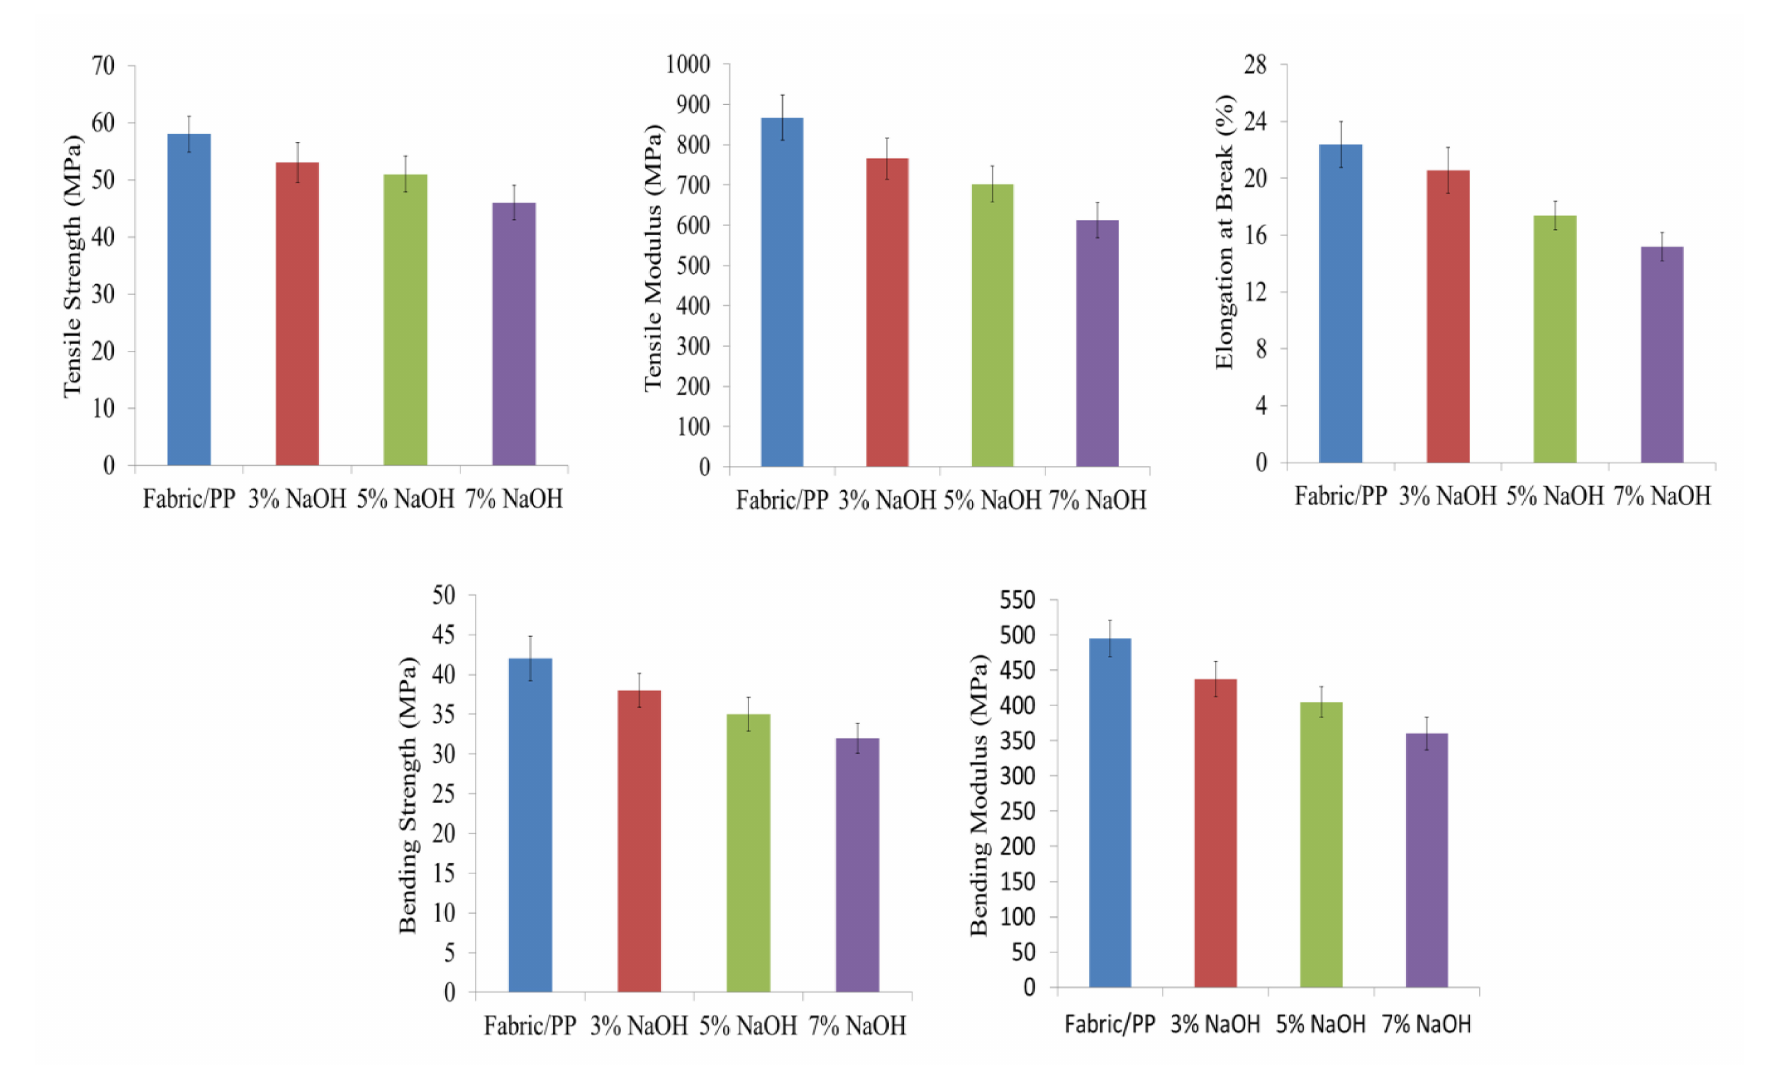
Figure 4. Effect of alkali on the mechanical properties of the